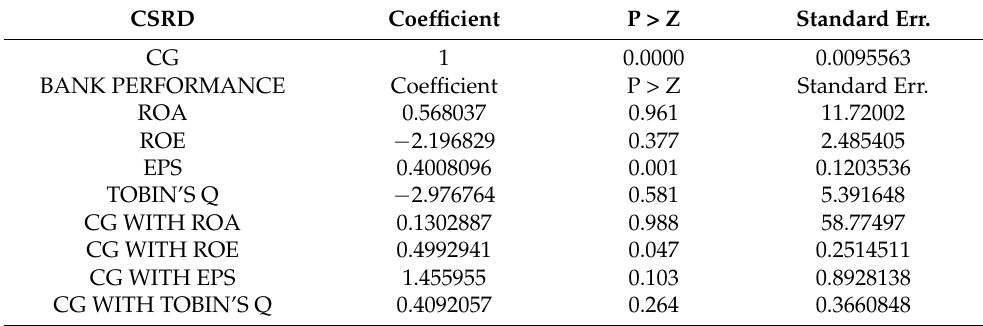
Table 4. Result of mediating role of corporate social responsibility disclosure between corporate governance and bank